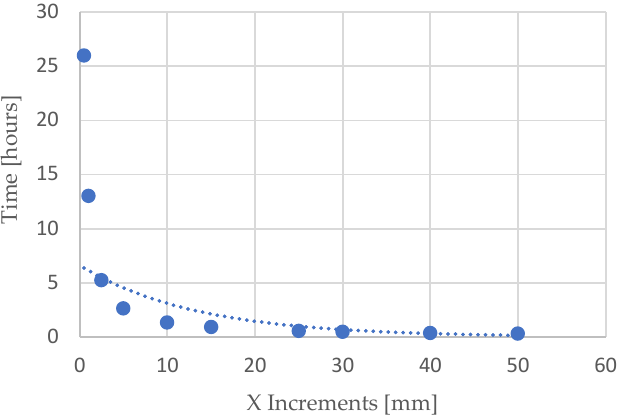
Figure 22. Influence of X -axis increments with constant 10 mm Z increments (with exponential fitting).